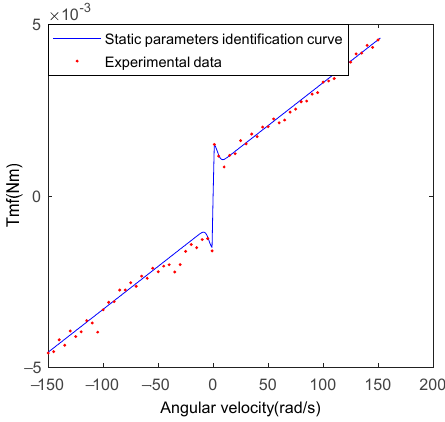
Figure 4. Schematic diagram of test bench.